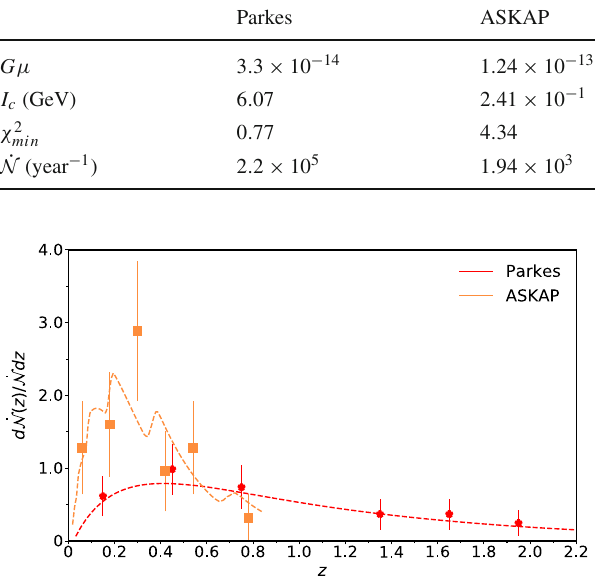
Fig. 3 The normalized observed event rate per redshift from Parkes (red) and ASKAP (orange), and theoretical fitting curve using SCSs model are shown with dashed lines. The observational parameters are listed in Table 2. The χ 2 are 0 . 77 for Parkes and 4 . 34 for ASKAP. min The corresponding parameter values with event rates per year are listed in Table